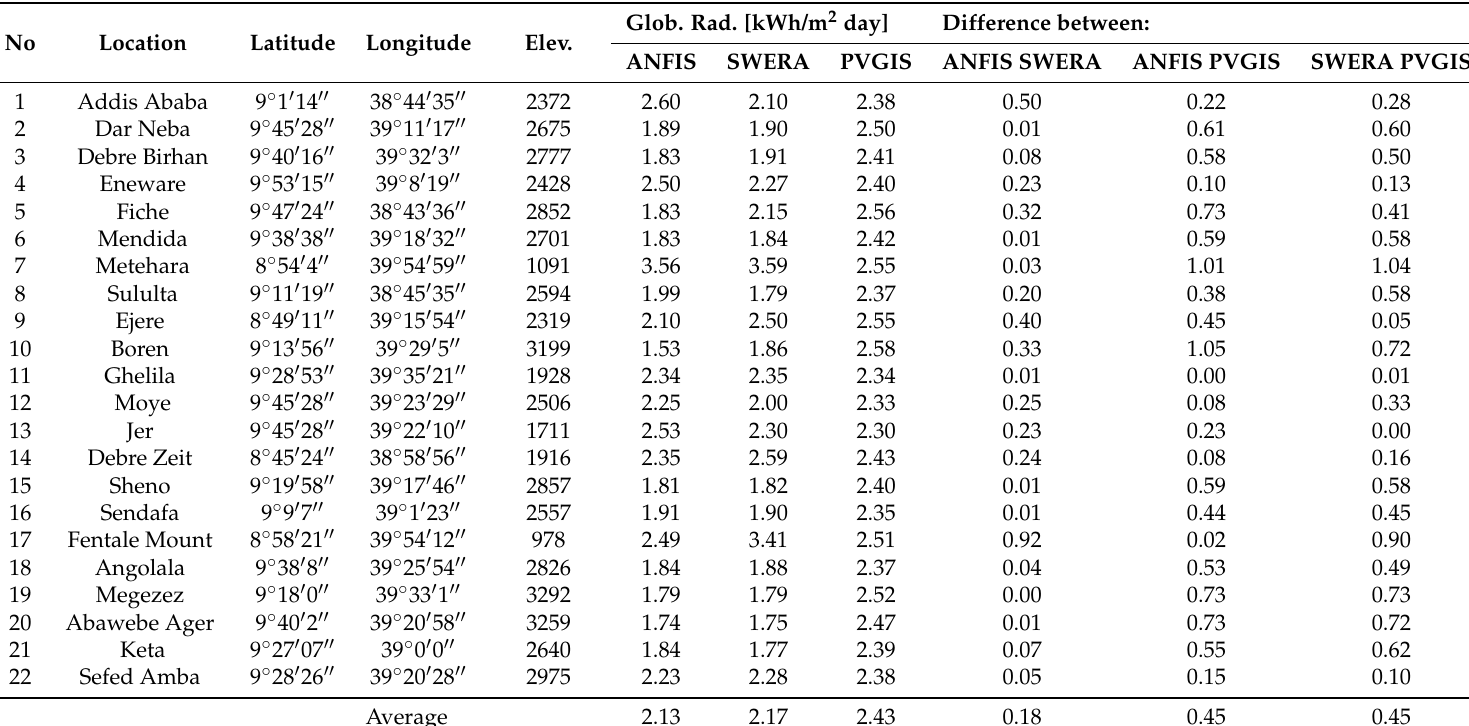
Table 2. Comparison of ANFIS model output with global horizontal (GHI) obtained from SWERA and PVGIS for selected